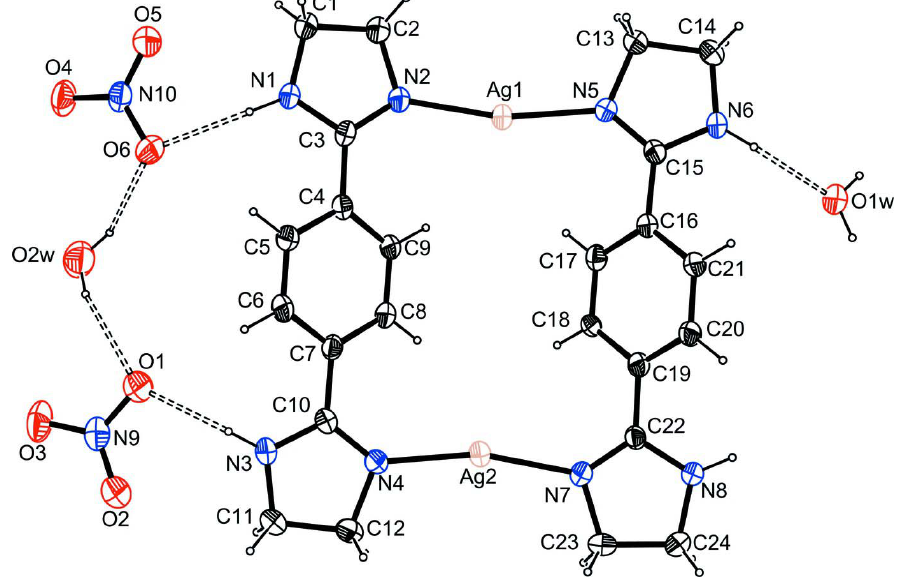
View of compound (I) with the atom-labelling scheme. Displacement ellipsoids are drawn at the 30% probability level. Hydrogen bonds are shown as dashed lines. H atoms are represented as small spheres of arbitrary